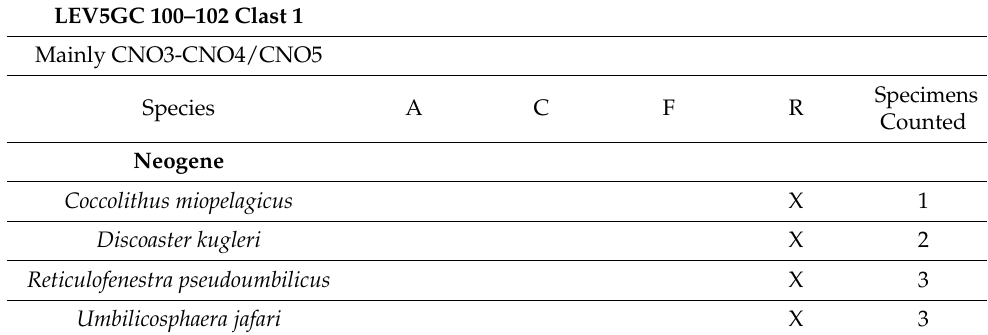
Table A24. Moscow